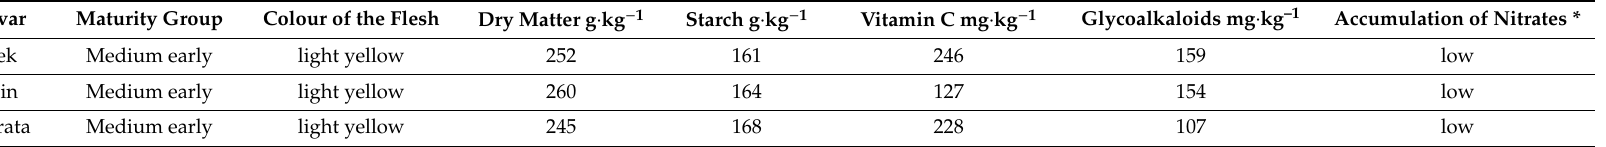
Table 1. Description of three potato cultivars grown in the experiment—factor I [27].